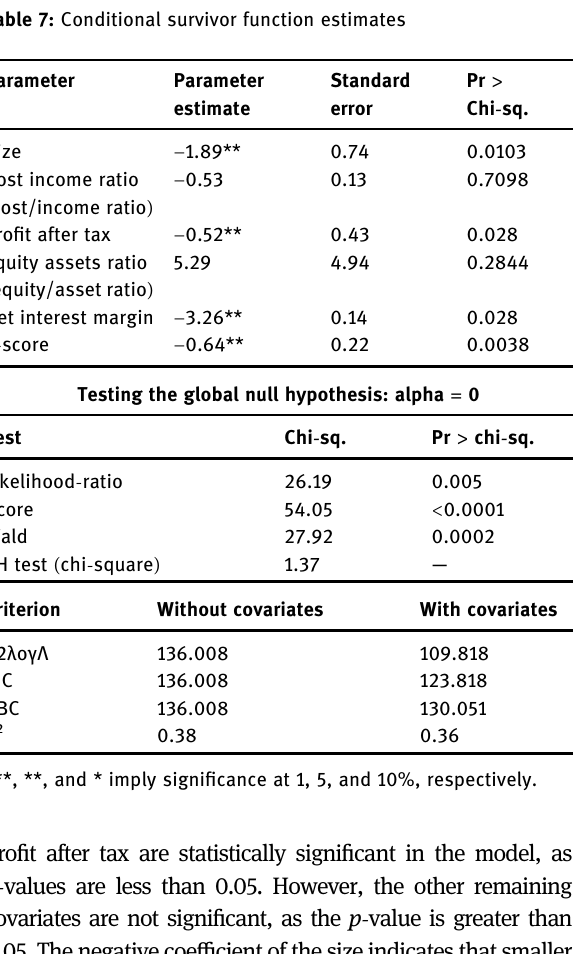
Table 7: Conditional survivor function